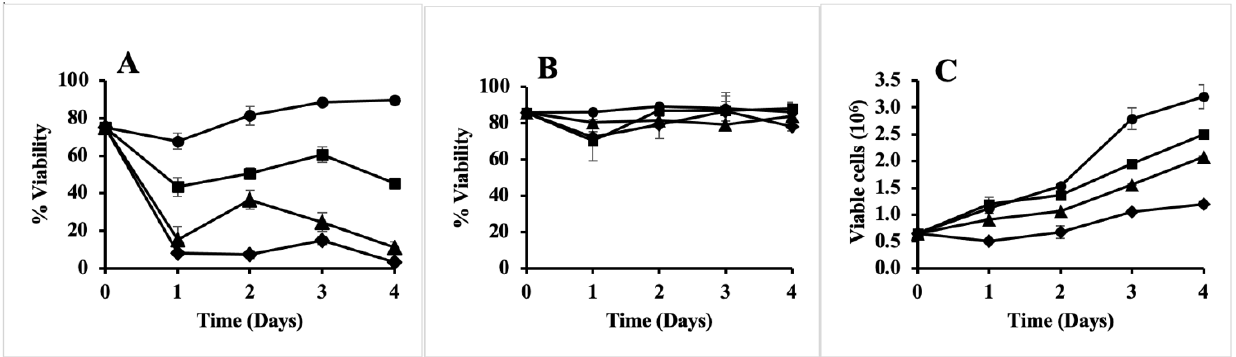
Figure 6. Cytotoxic and anti-proliferative activities of rhubarb stalks. Human breast cancer cells, MCF-7, were treated with either crude extract from rhubarb ( A ) or the gel-filtration purified fraction, GF-F6 ( B , C ), for the indicated times. The proportions of viable cells are shown in ( A , B ), while the total number of viable cells is shown in ( C ). Volumes of rhubarb extract or purified GF-F6 used were 0 μL (circles), 5 μL (squares), 10 μL (triangles), and 15 μL (diamonds). The average and standard deviations of each experiment done in triplicate are shown. Error bars are shown for all data points, but are not visible for some if they are smaller than the symbol sizes.